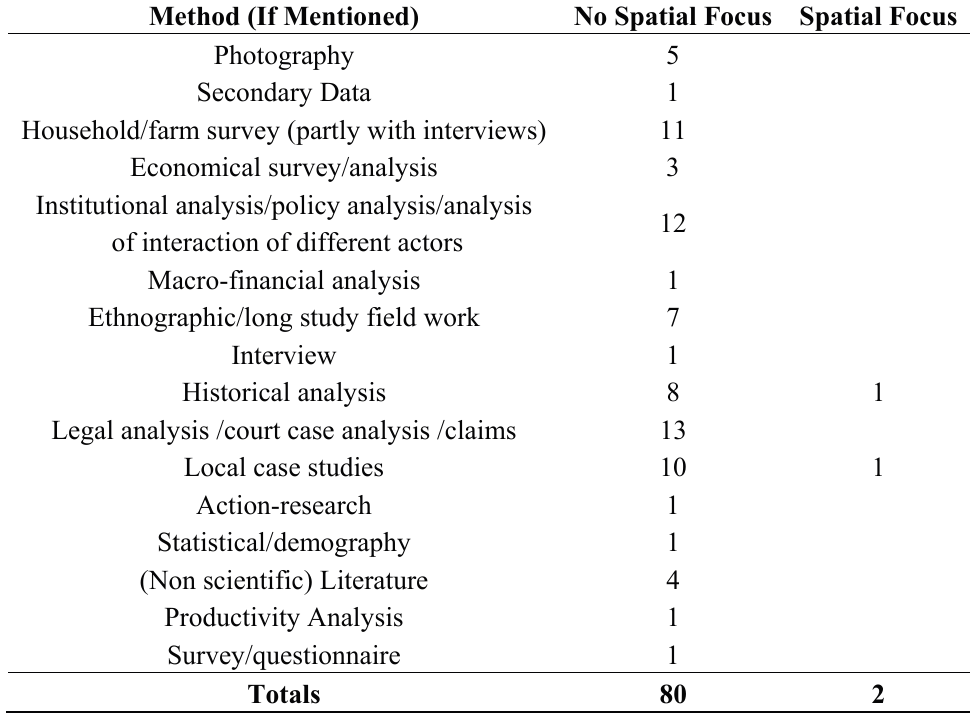
Table 3. Grouped methods mentioned in all abstracts of the “ Land Divided ” conference